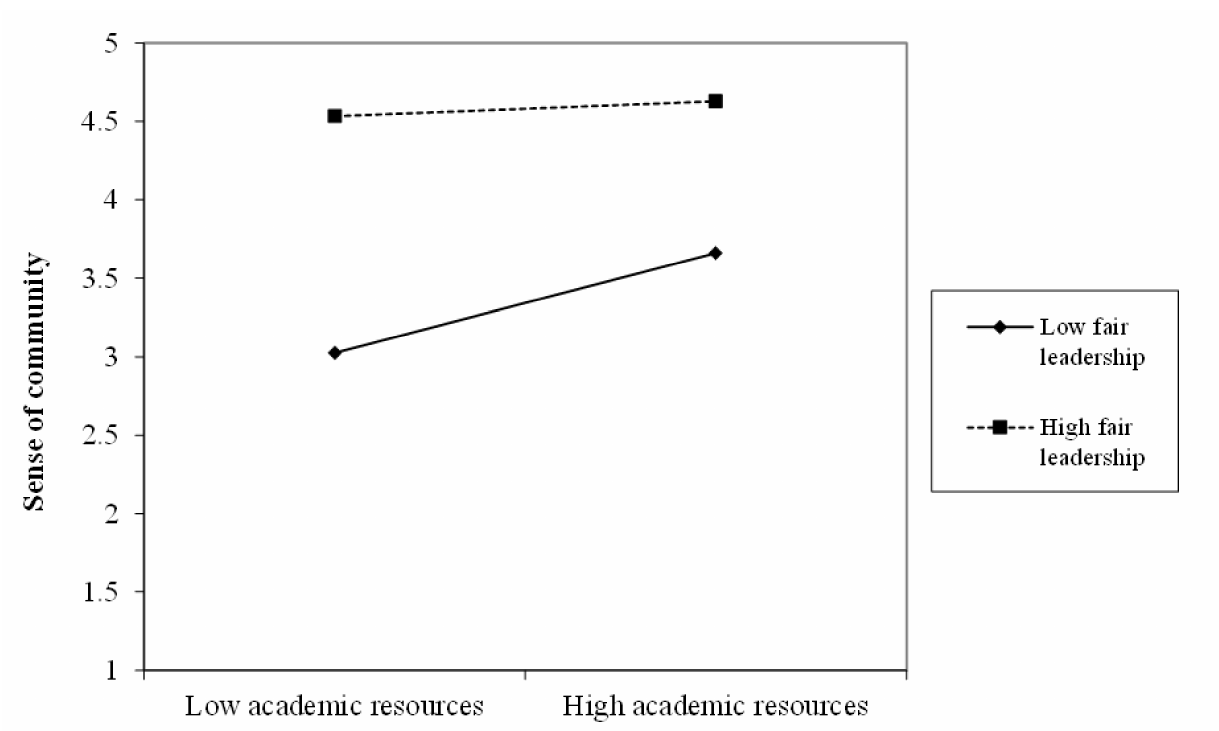
Figure 1. Interaction between academic resources and fair leadership predicting social community at